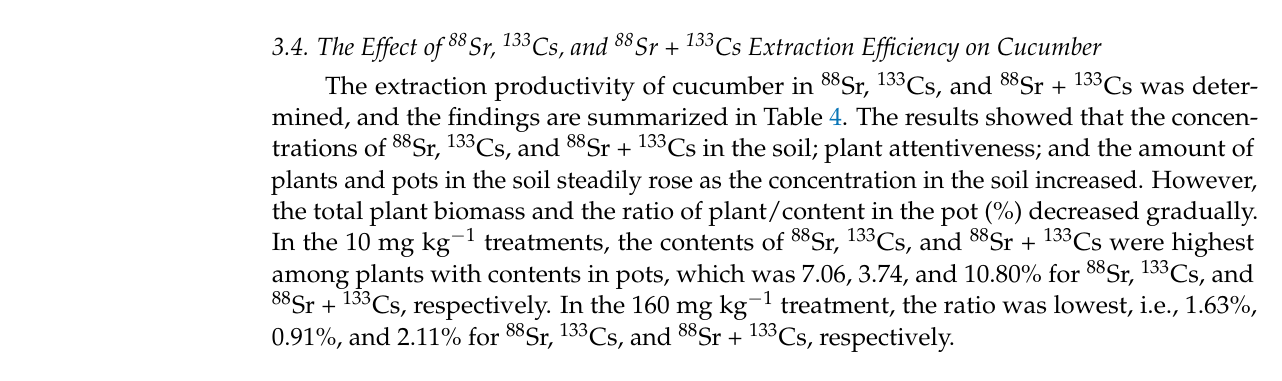
Table 4. The effect of 88 Sr, 133 Cs, and 88 Sr + 133 Cs extraction efficiency of cucumber. 88 Sr